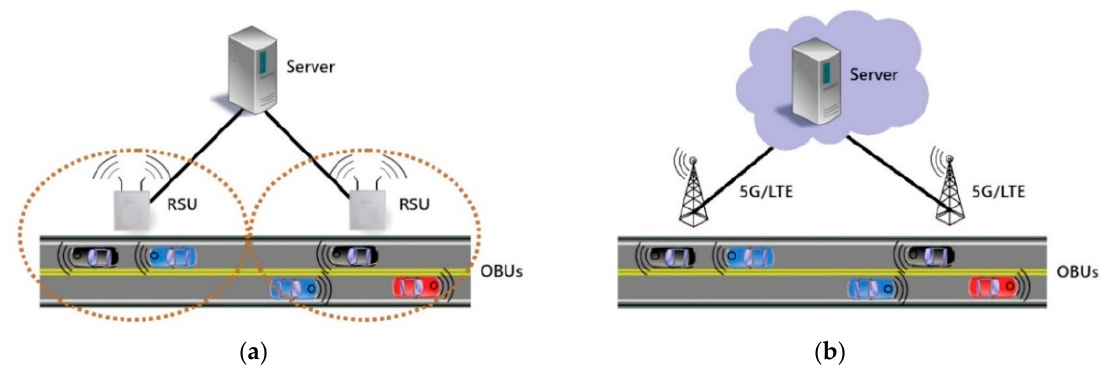
Figure 1. Examples of VANET configurations: ( a ) VANET with RSUs; ( b ) VANET with cloud.